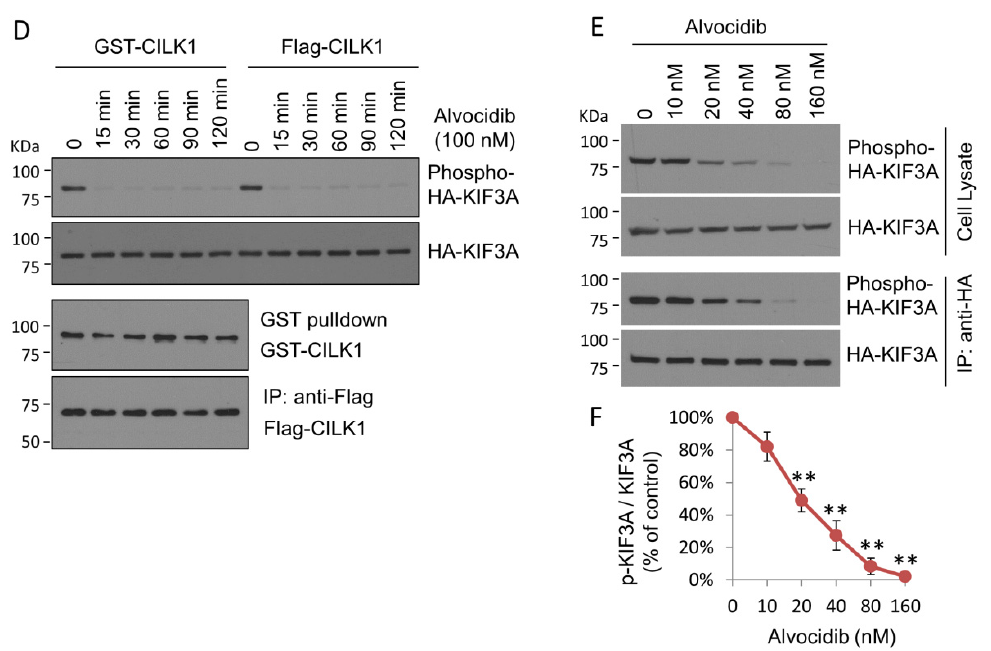
Figure 1. Alvocidib effect on CILK1 phosphorylation of KIF3A in cells. ( A ) GST-CILK1 or Flag-CILK1 was co-transfected with HA-KIF3A (substrate) into HEK293T cells. Forty-eight hours after transfection, cells were treated with increasing concentrations of Alvocidib in DMSO for 15 min before lysis. HA-KIF3A was immunoprecipitated from cell extracts with mouse monoclonal HA-tag antibody (12CA5). Both cell extracts and anti-HA immunoprecipitates were Western blotted for total and phospho-T672 KIF3A. ( B ) HEK293T cells co-transfected with GST-CILK1 and HA-KIF3A were treated with various doses of Alvocidib or AT7519. Cell extracts were Western blotted for total and phospho-T672 KIF3A and GST-CILK1. ( C ) The phospho-T672 versus total KIF3A ratio was plotted against the concentrations of drugs. Shown is average ± SD, n = 3 independent experiments; * p < 0.05; ** p < 0.01. ( D ) GST-CILK1 or Flag-CILK1 was co-transfected with HA-KIF3A into HEK293T cells. Cells were treated with 100 nM Alvocidib in a time course. Cell extracts were Western blotted for total and phospho ‐ T672 KIF3A. From cell extracts, GST ‐ CILK1 and Flag ‐ CILK1 proteins were recovered by glutathione agarose beads and anti ‐ FLAG M2 agarose beads, respectively, and then Western blotted by a CILK1 antibody. ( E ) HEK293T cells co ‐ transfected with GST ‐ CILK1 and HA ‐ KIF3A were treated with Alvocidib in the nanomolar range for 15 min before lysis, protein extraction, and immunoprecipitation. Both cell extracts and anti ‐ HA immunoprecipitates were Western blotted for total and phospho ‐ T672 KIF3A. ( F ) Phospho ‐ T672 of HA ‐ KIF3A in anti ‐ HA immunoprecipitates was plotted against various concentrations of Alvocidib. Shown is average ± SD, n = 3 independent experiments; ** p < 0.01.